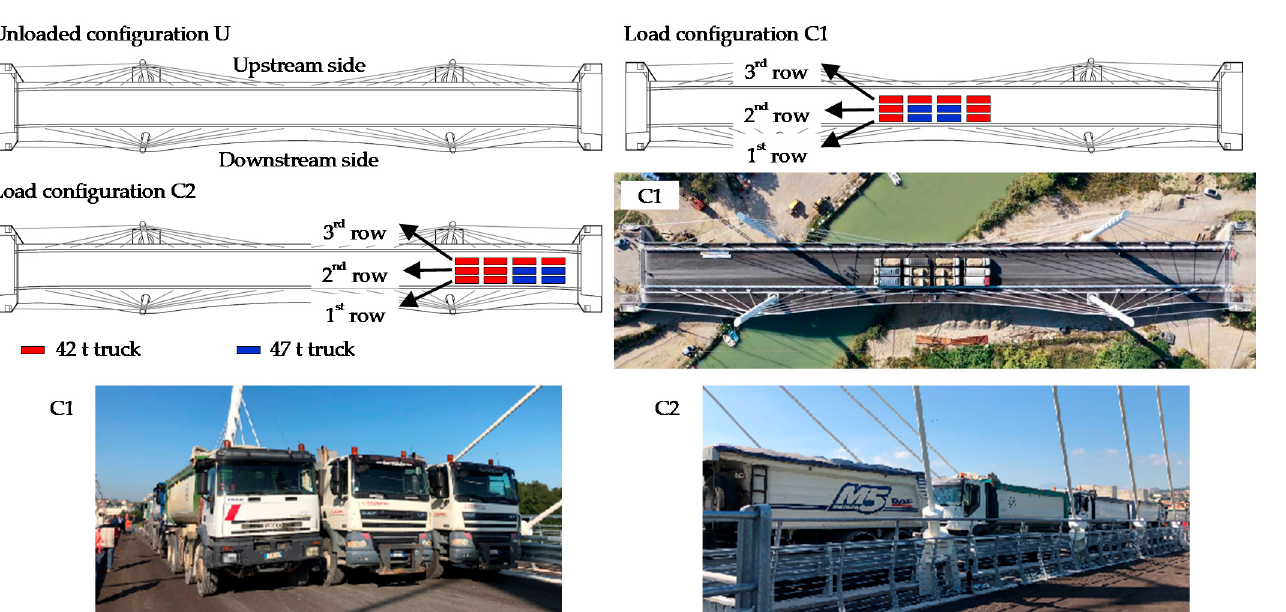
Figure 2. Schemes and characteristics of the bridge (measures are in meters): ( a ) side and plan schemes, ( b ) cross-section A-A, ( c ) cross-section B-B, and ( d ) detail of the pylon cross-sections.